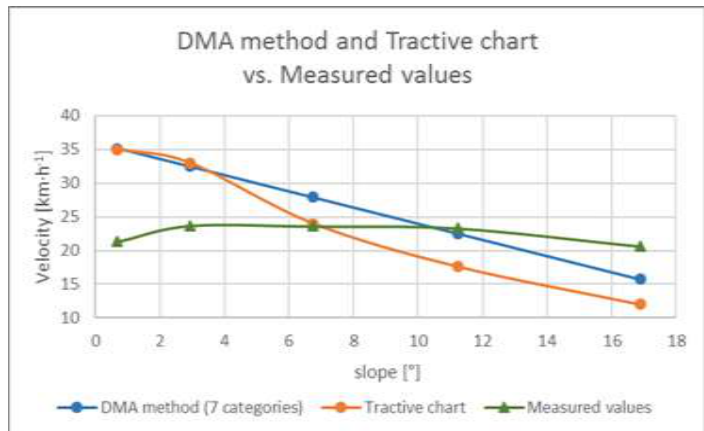
Fig. 3. The Illustration of the comparison of the calculated and measured values